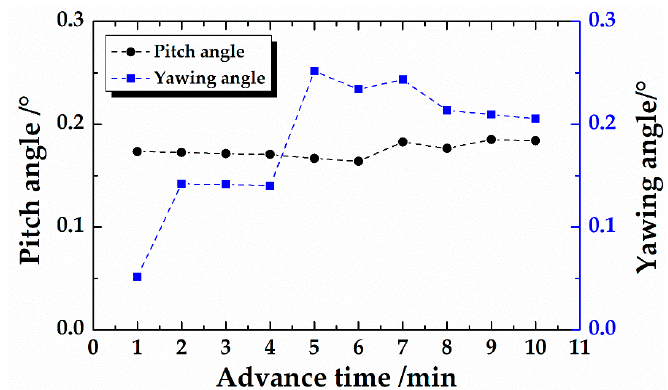
Figure 17. Pitch angle and yawing angle measured data.